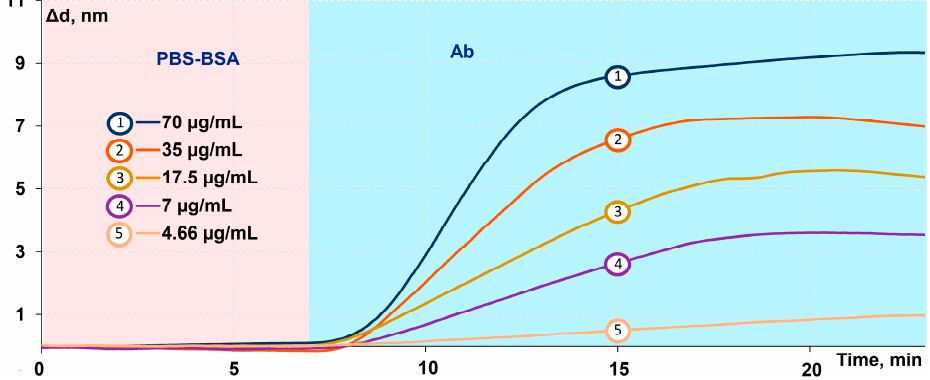
Figure 5. Comparative analysis of the biolayer thickness and the rate of its formation depending on FA antibody concentration. The solutions of FA antibody in concentrations of 4.66, 7, 17.5, 35, and 70 µg/mL were pumped along the sensor chips that had FA–gelatin immobilized on their surface.